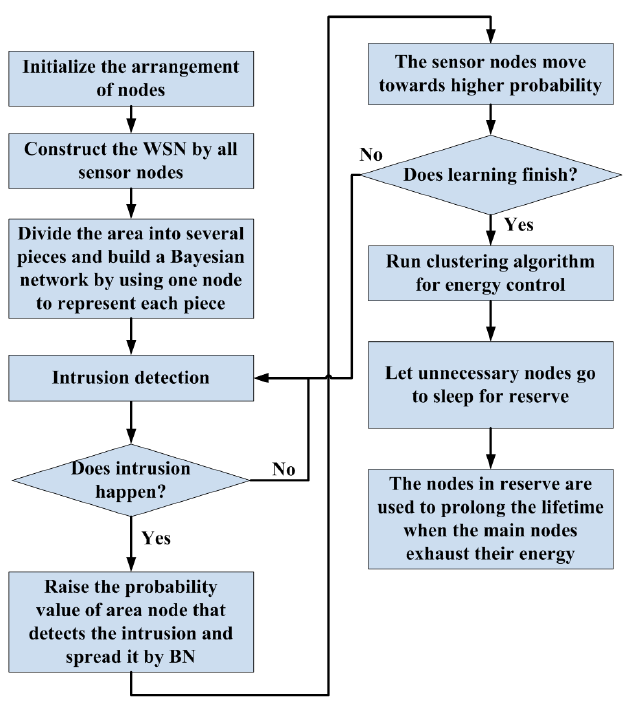
Figure 6. The procedure of adaptive learning and energy control.